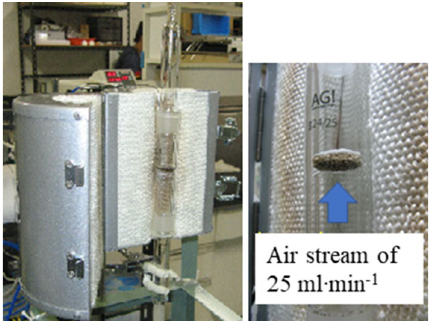
Figure 16. Experimental set-up for evaluating the carbon combustion characteristics of a porous alumina filter coated by the carbon combustion catalyst.